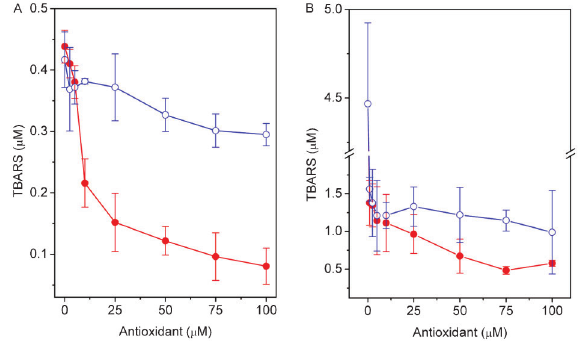
Figure 3. Effect of 4-NC (filled circles) and a -tocopherol (open circles) on TBARS formation in erythrocyte ghost membranes oxidized with AAPH ( A ) or FeSO 4 +H 2 O 2 ( B ). Ghosts (4 mg protein/mL) were incubated with the desired concentrations of 4-NC for 1.5 h at 37 6 C. Erythrocyte ghost membranes were oxidized by incubation with 50 mM AAPH (3 h at 37 6 C) or 0.2/2 mM FeSO 4 /H 2 O 2 (1 h at 37 6 C). 4-NC: 4-nerolidylcatechol; TBARS: thiobarbituric acid-reactive substances; AAPH: 2,2 9 - azobis(2-aminopropane)